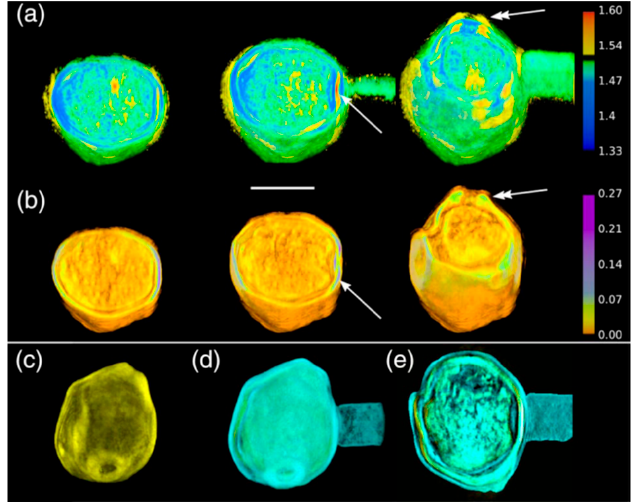
Figure 4. Betula pollen grain image reconstructed by tomographic di ff ractive microscopy (TDM) under Born approximation. ( a , b ) Volumetric cuts of a refraction image and an absorption image, respectively. Scale bar: 10 µ m. ( c ) Outer view of the pollen: Image of the absorption component. ( d ) Outer view of the pollen: Image of the complex index of refraction. ( e ) ( x-y ) cut through the pollen [44]. The resolution of TDM under the Born approximation is determined by the accessible Fourier domain, which depends on the configuration of the illumination and detection [45], which we will discuss in the following